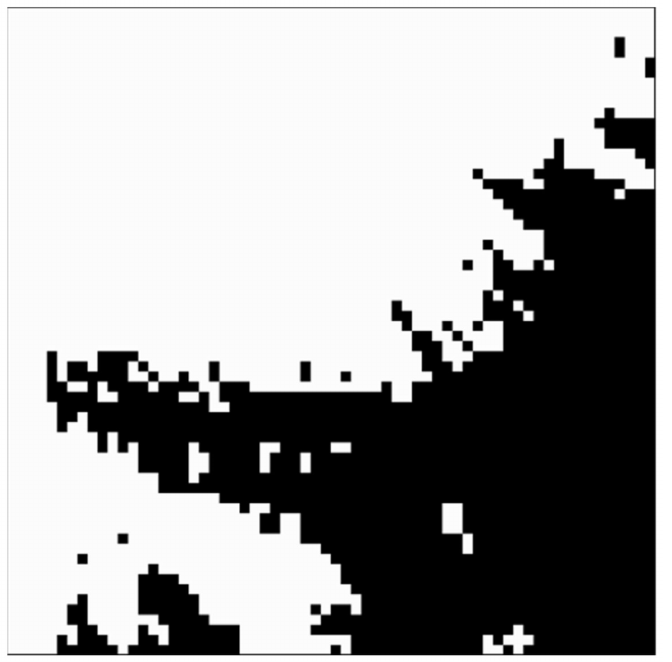
Figure 7. Diagram of a PVPS map. A PVPS map is a 64 × 64 binary image. Potential visible patches are marked white, and not visible ones are marked